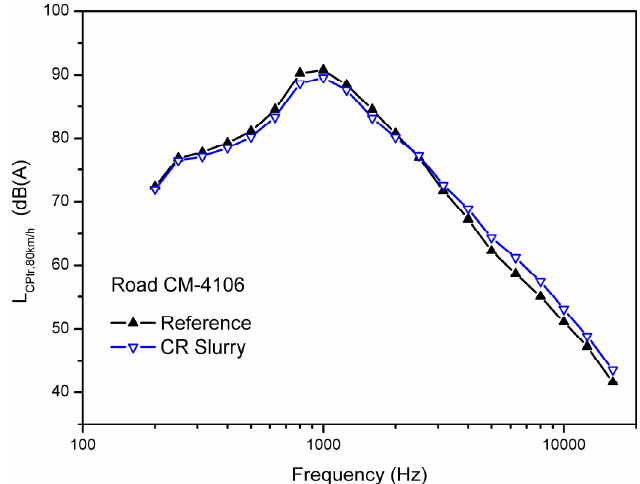
Figure 5. Comparison of the representative close proximity noise spectra of the different test sections for the reference speed (v = 80 km/h). ref